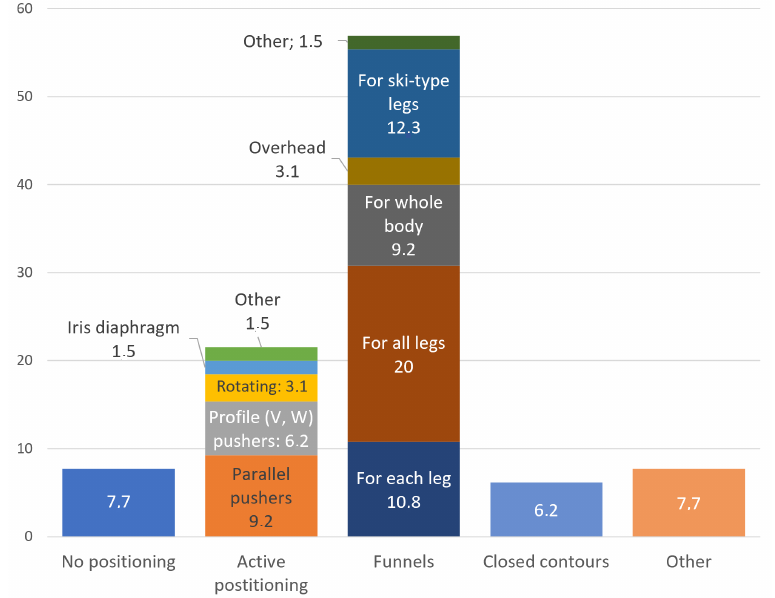
Figure 2. The percentage of the usage of the positioning devices of certain types determined during the patents’